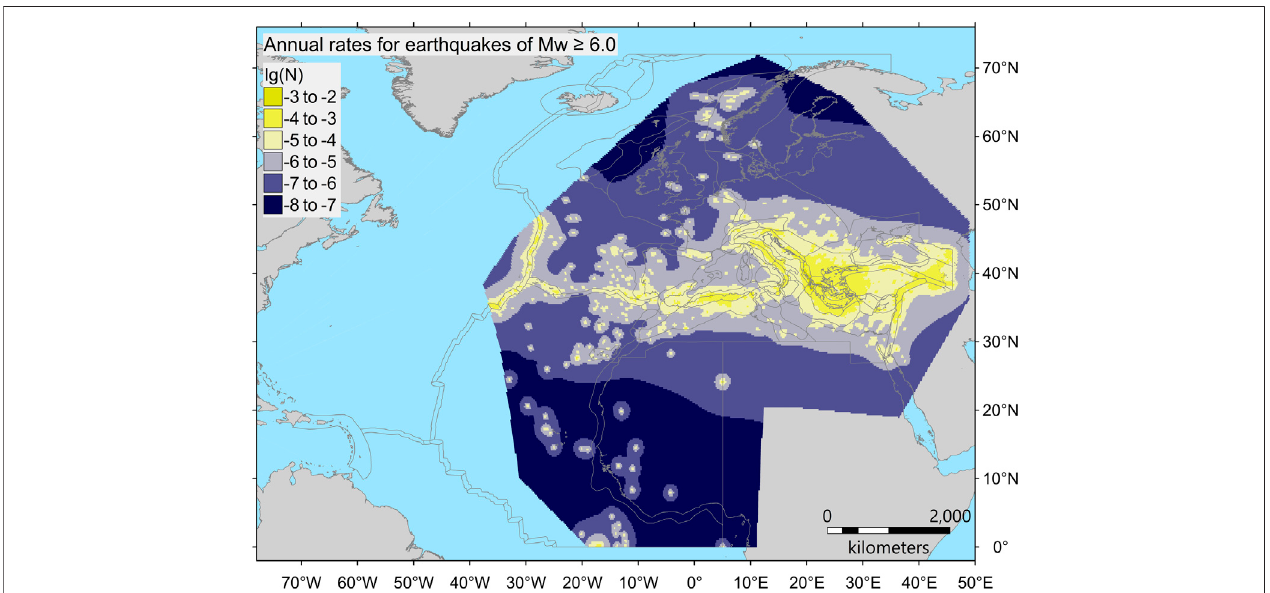
FIGURE 8 | Map showing the geographic distribution of annual earthquake rates (common logarithm scale) for Mw ≥ 6.0 for the BS/SBS seismicity model types, adopting the cut-off distance of 5 km for the seismicity separation between PS and BS. This separation is done by assigning the earthquakes located within the given cut-off distance from the PS sources ( Figures 4 , 5 ) to the PS/SPS types and the remaining earthquakes to the BS/SBS types. The hazard model also includes the distribution of annual earthquake rates calculated with the cut-off distance of 10 km.